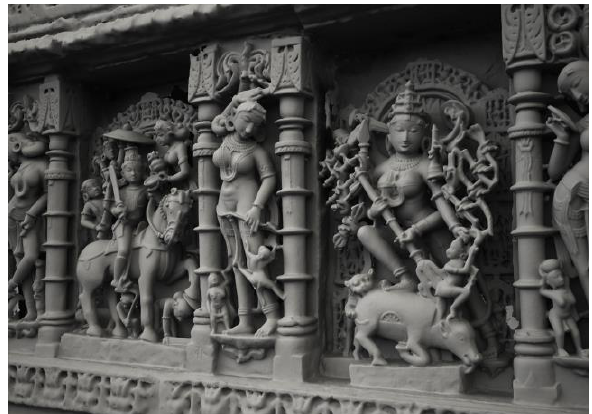
Figure 10. Mesh of sculpture obtained from close-range structured light scanning at Rani ki Vav © CDDV